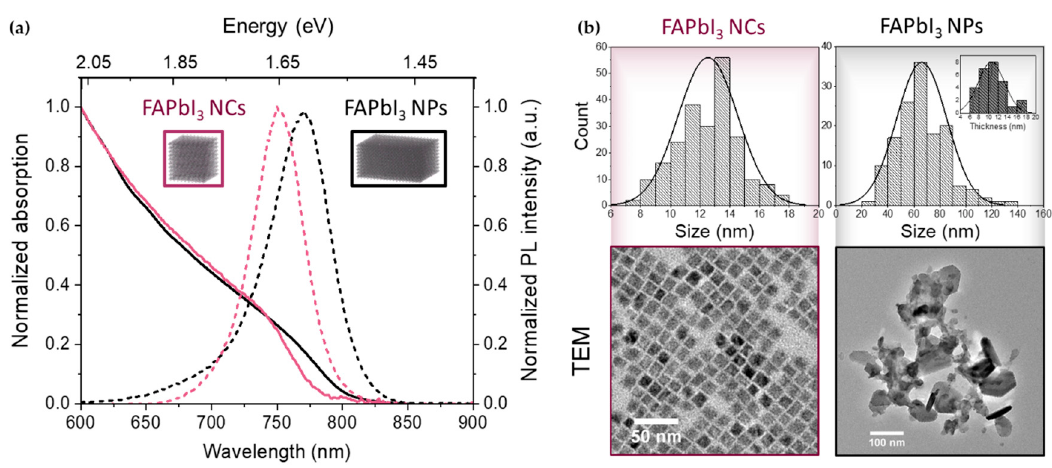
Figure 1. ( a ) Absorption (solid line) and photoluminescence (dashed line) spectra of the corresponding colloidal FAPbI 3 samples (nanocrystals (NCs) in purple, thick nanoplates (NPs) in black). ( b ) TEM characterization of the FAPbI 3 NCs and thick NPs. Inset: histogram corresponding to the NP thickness.